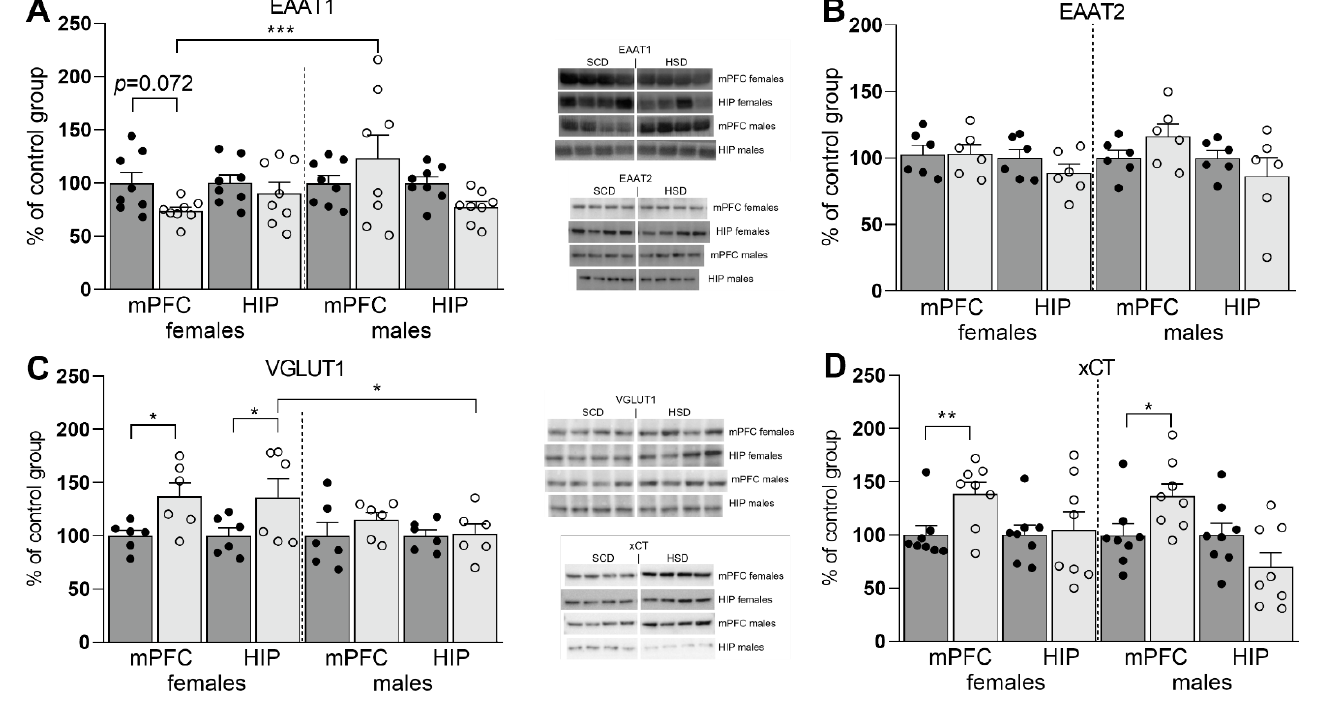
Figure 5. Expression of the EAAT1 ( A ), EAAT2 ( B ), VGLUT1 ( C ), and xCT ( D ) proteins in the mPFC and HIP of female and male off spring with representative immunoblots. SCD—dark gray bars with and HIP of female and male offspring with representative immunoblots. SCD — dark gray bars with black dots as individual data points, HSD—light gray bars with transparent dots as individual data black dots as individual data points, HSD — light gray bars with transparent dots as individual data points.* p < 0.05; ** p ≤ 0.01; *** p ≤ points.* p < 0.05; ** p ≤ 0.01; *** p ≤ 0.001.